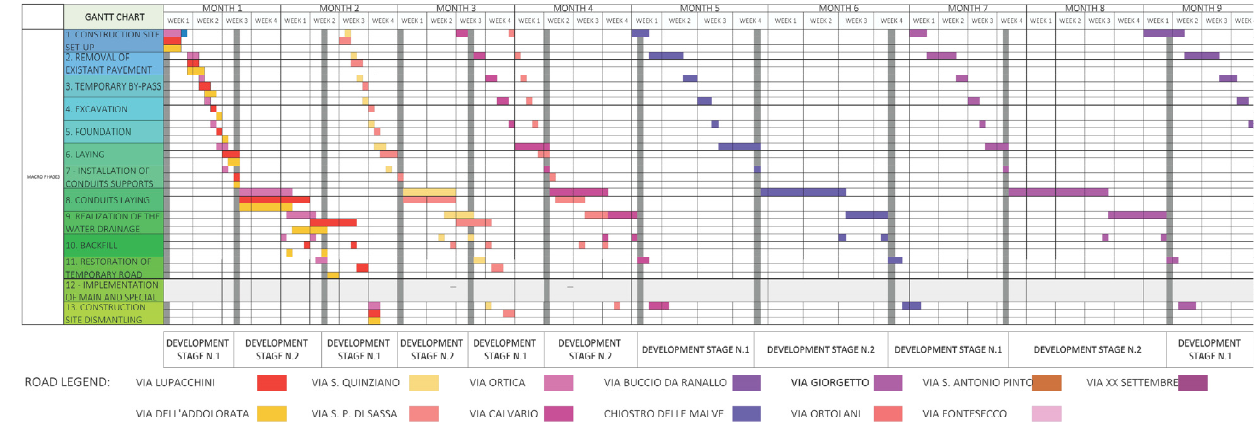
Figure 5. Parallel planning of construction works in a historic center, where the activities path indicates the execution of the works for each distributed construction site and the colors indicate the streets affected by the works.